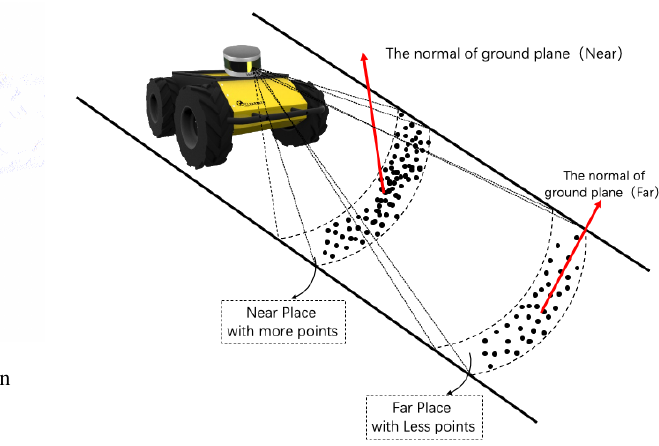
Figure 5. The Example of Ground Plane Estimation Proposes. The number of estimated points on different area are